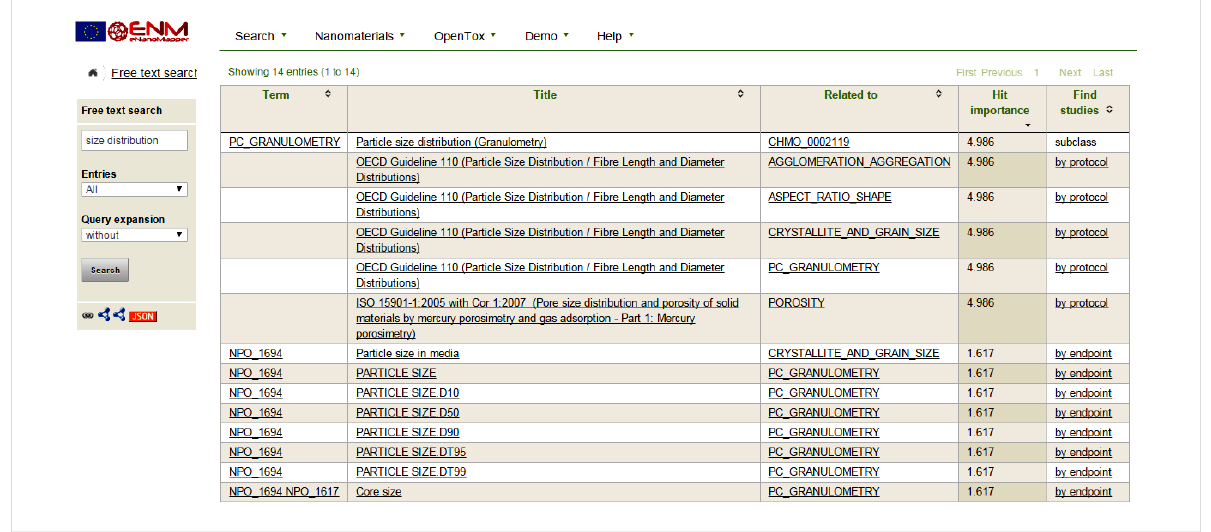
Figure 1: Screenshot illustrating free text search finding ontology annotated database entries (e.g. protocols and endpoints in the second column). The last column is a link leading to a list of